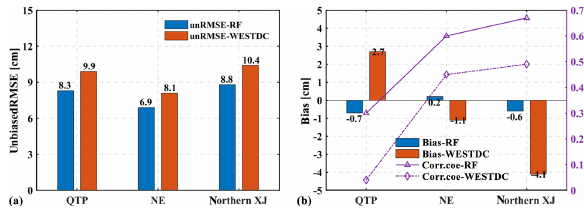
Figure 9. The validation of RF and WESTDC snow depth products in three stable snow cover areas over China with respect to (a) the unbiased RMSE, (b) bias, and correlation coefficient.